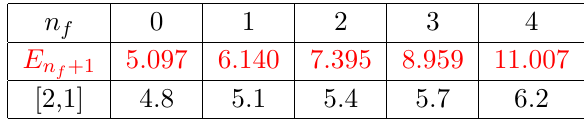
(red) and the [2 , 1] Padé approximant of e F nf +1 for 0 ≤ n 4 f f ≤